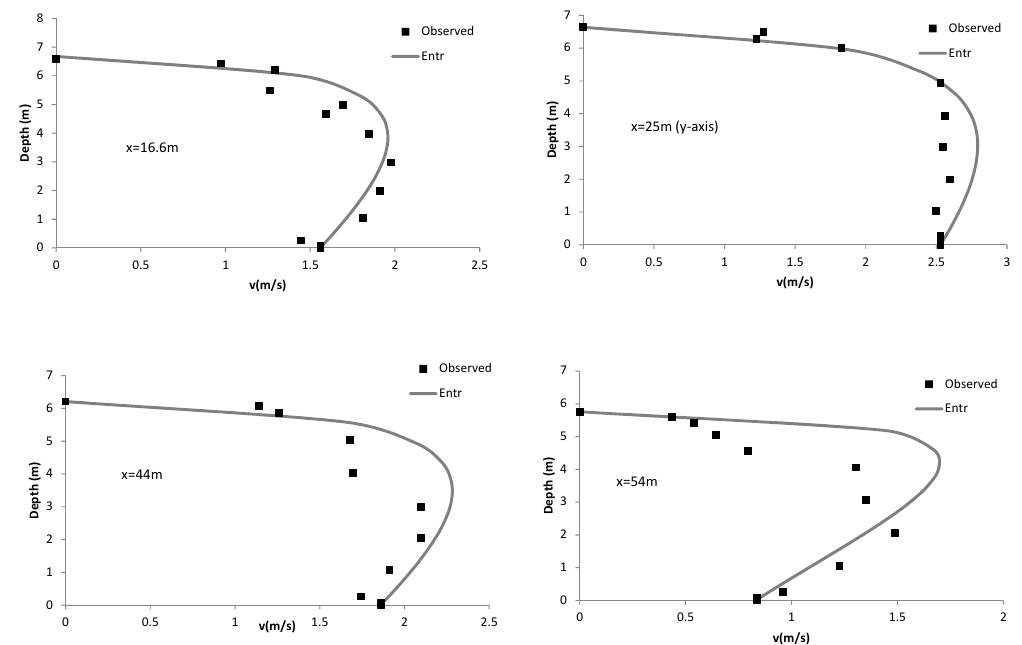
Figure 8. Velocity profiles estimated by entropy method (Equations (1) and (5)) plotted against velocity points sampled by current meter along four verticals during the highest flood of the velocity dataset at the Ponte Nuovo gage site. x is the distance from the left bank, while the y ‐ axis represents the vertical where u max occurs.